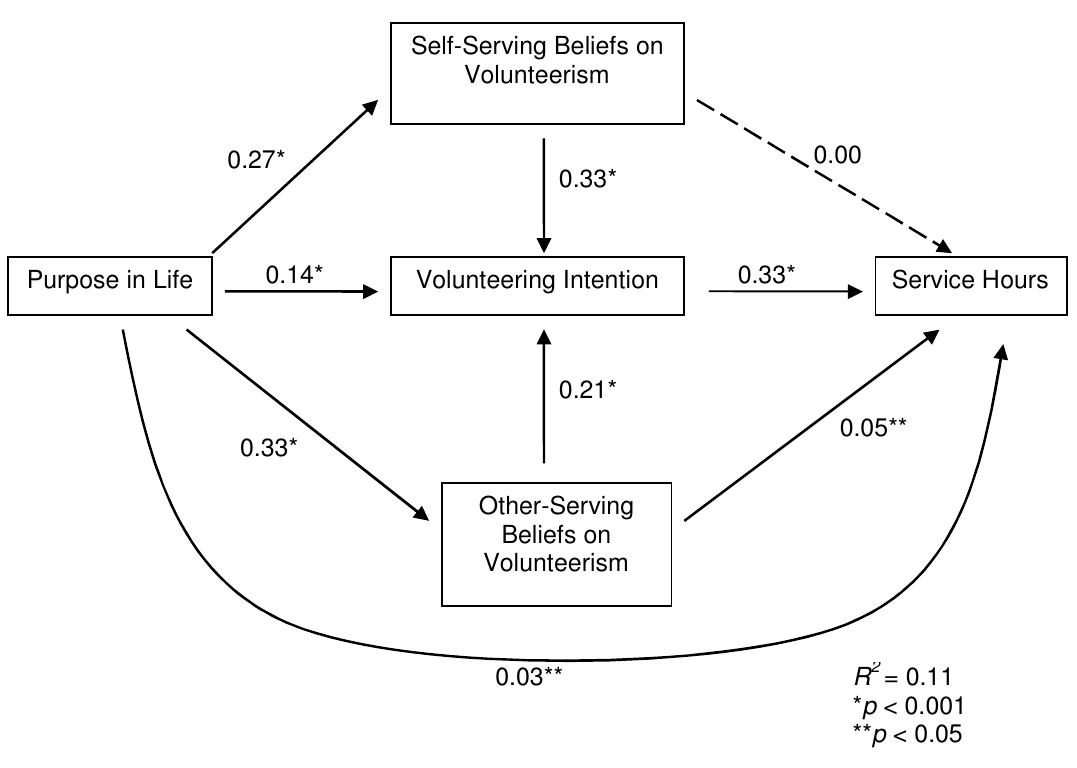
FIGURE 1. Path model showing inter-relationships among purpose in life, volunteering beliefs, intention, and